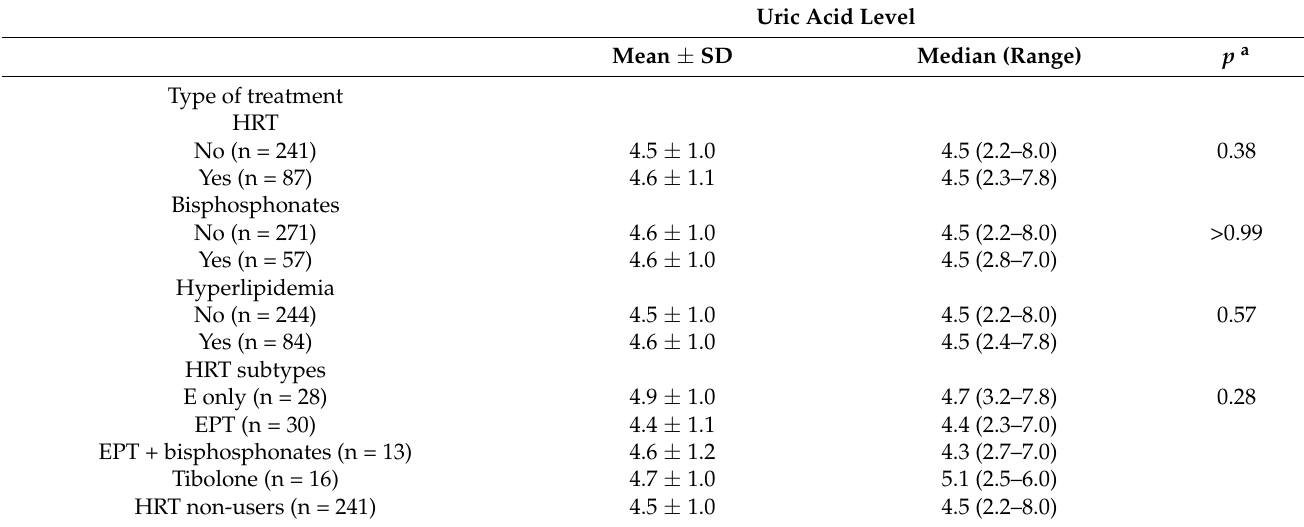
Table 4. Association of HRT and bisphosphonates with uric acid